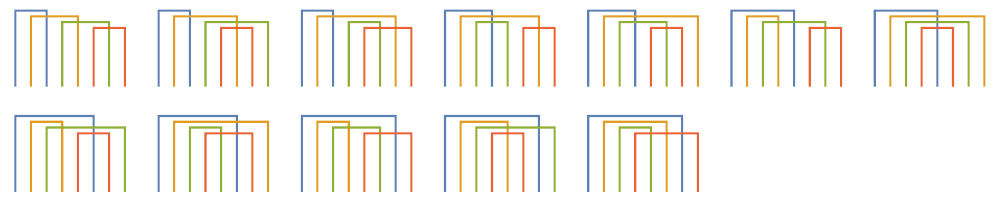
Figure 11 . Diagrams with three intersections contributing to the 8th moment as (cid:17) 3 .